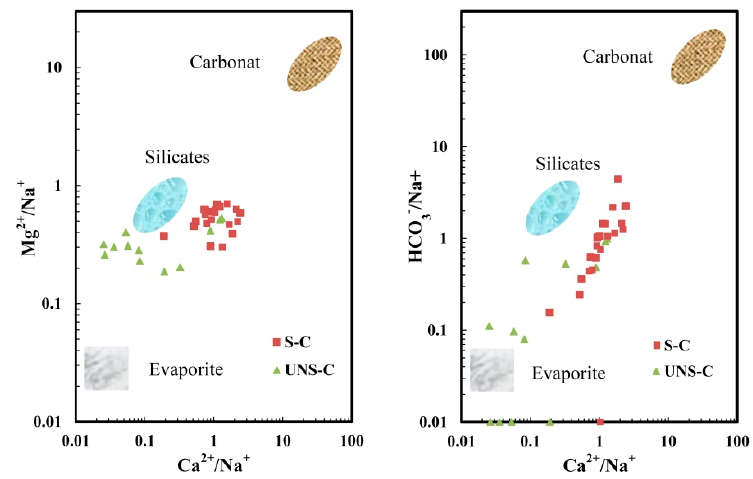
Figure 6. Mixing diagram of ion proportion for the stable catchment (S-C) and unstable catchment (UNS-C) in Qingtu Lake.